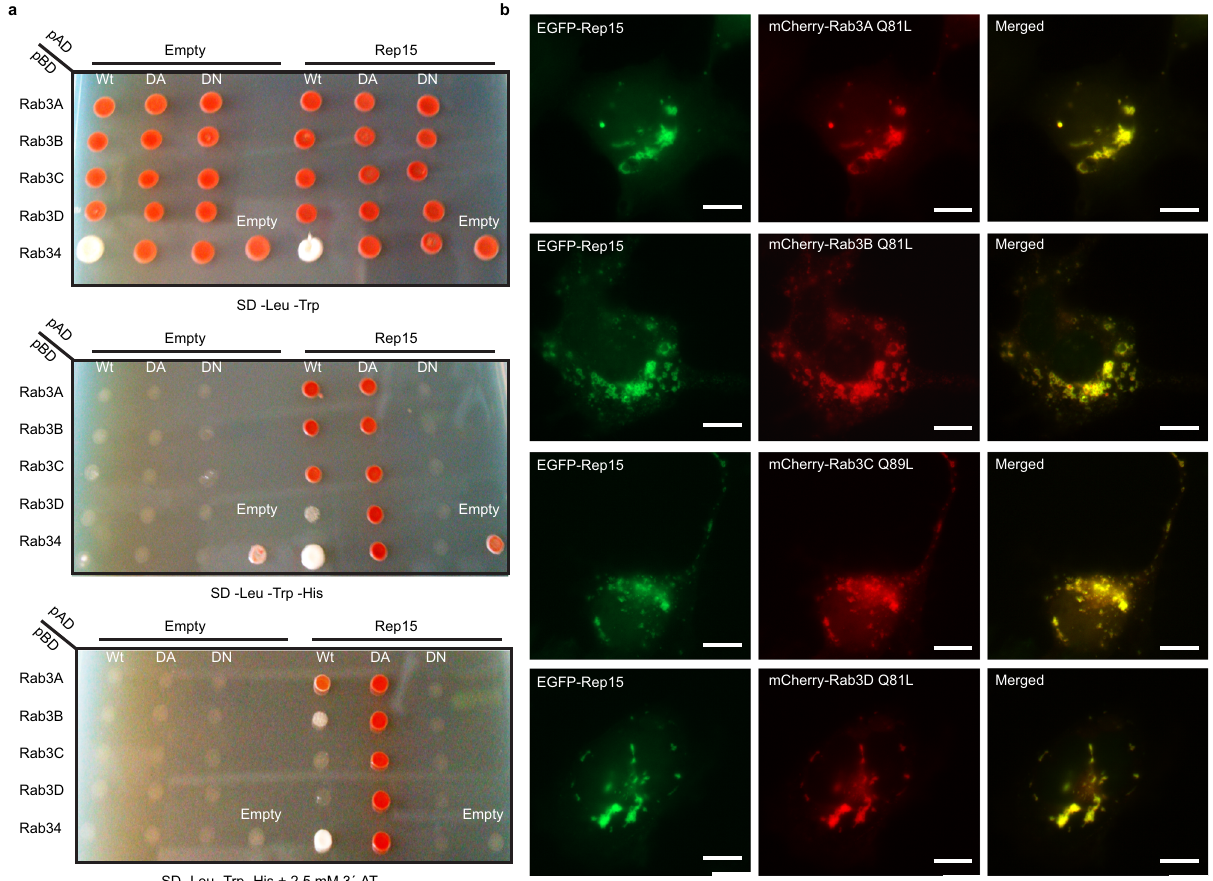
Fig. 2 Identi fi cation and validation of novel Rep15 interaction partners. a A yeast two-hybrid screen between Rep15 (pGADT7) and wild type (Wt), dominant active (QL) and dominant inactive (SN/TN) form of Rab3A, Rab3B, Rab3C, Rab3D and Rab34 (pLexA) was performed. The cells were grown on SD-LW, SD-LWH and SD-LWH plus 2.5 mM 3-Aminotriazol (3 ′ -AT), a competitive inhibitor of the HIS3 gene product. Y2H analysis identi fi ed interactions between the Rep15 and Rab3 paralogs/Rab34. b – e Immuno fl uorescence of transiently co-expressed EGFP-Rep15 and mCherry-Rab3 paralogs in Cos7 cell line by fl uorescence microscopy. Merged images show strong co-localization between EGFP-Rep15 and mCherry tagged active Rab3 paralogs. Scale bars: 10 µ m. Experiments were repeated at least three times independently with similar